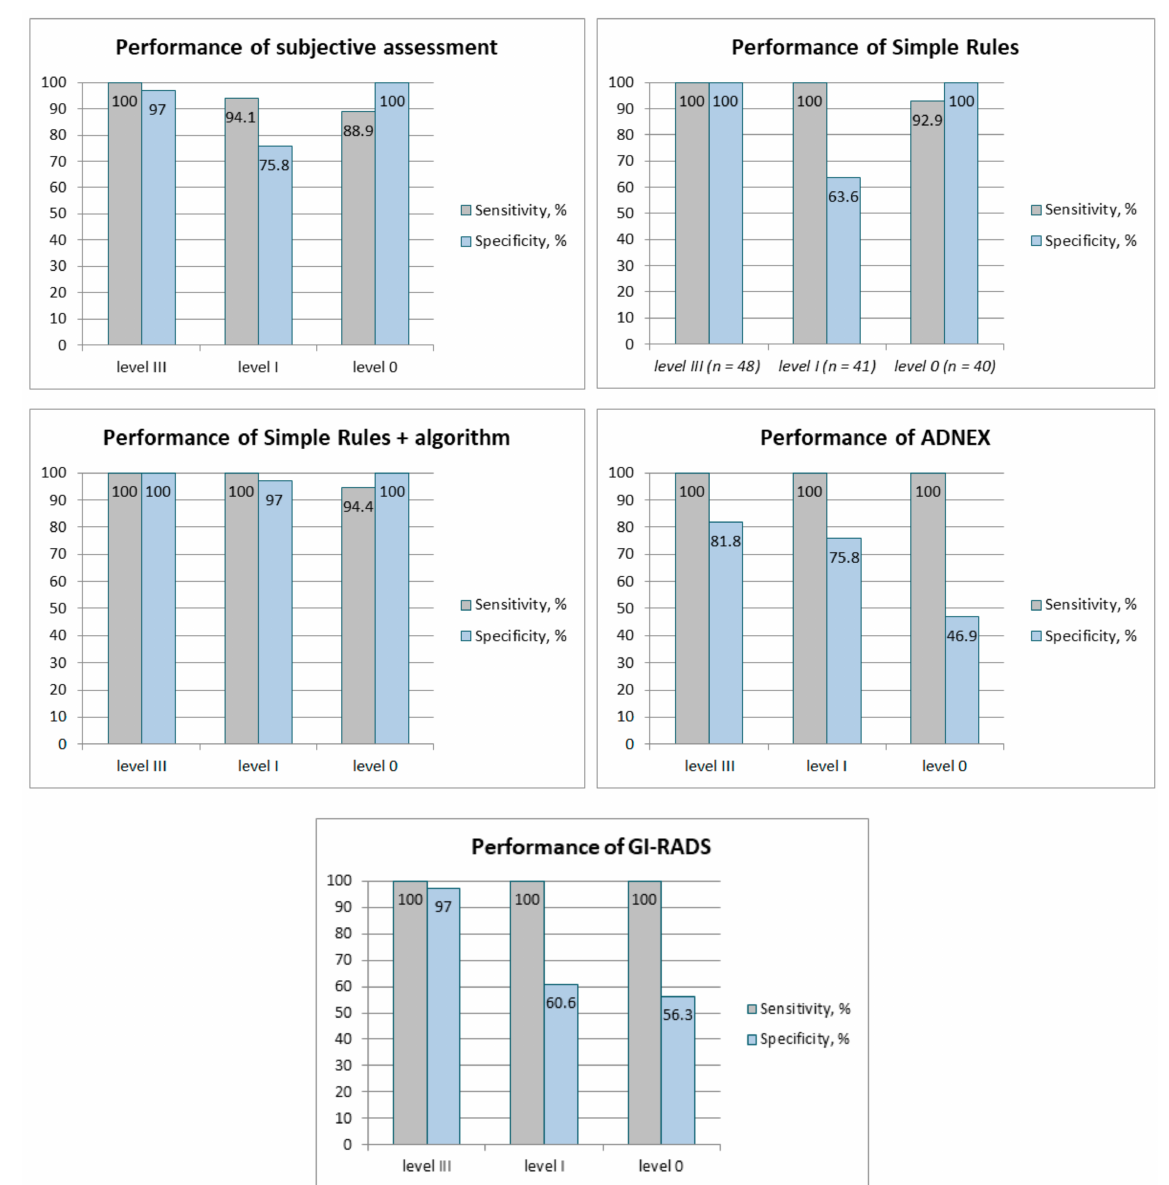
Figure 1. Sensitivity and specificity of different methods based on levels of